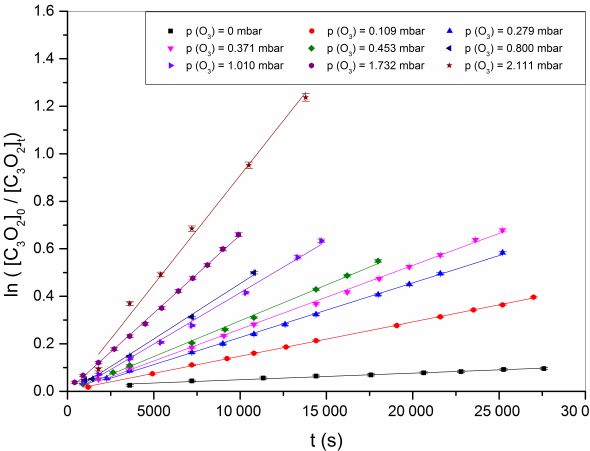
Figure 8. Depletion of C 3 O 2 (band centred at 2260cm − 1 ) and the formation of CO 2 (2300 to 2375cm − 1 ) and CO (2150 to 2210cm − 1 ) at different times during the reaction of C 3 O 2 with O 3 .